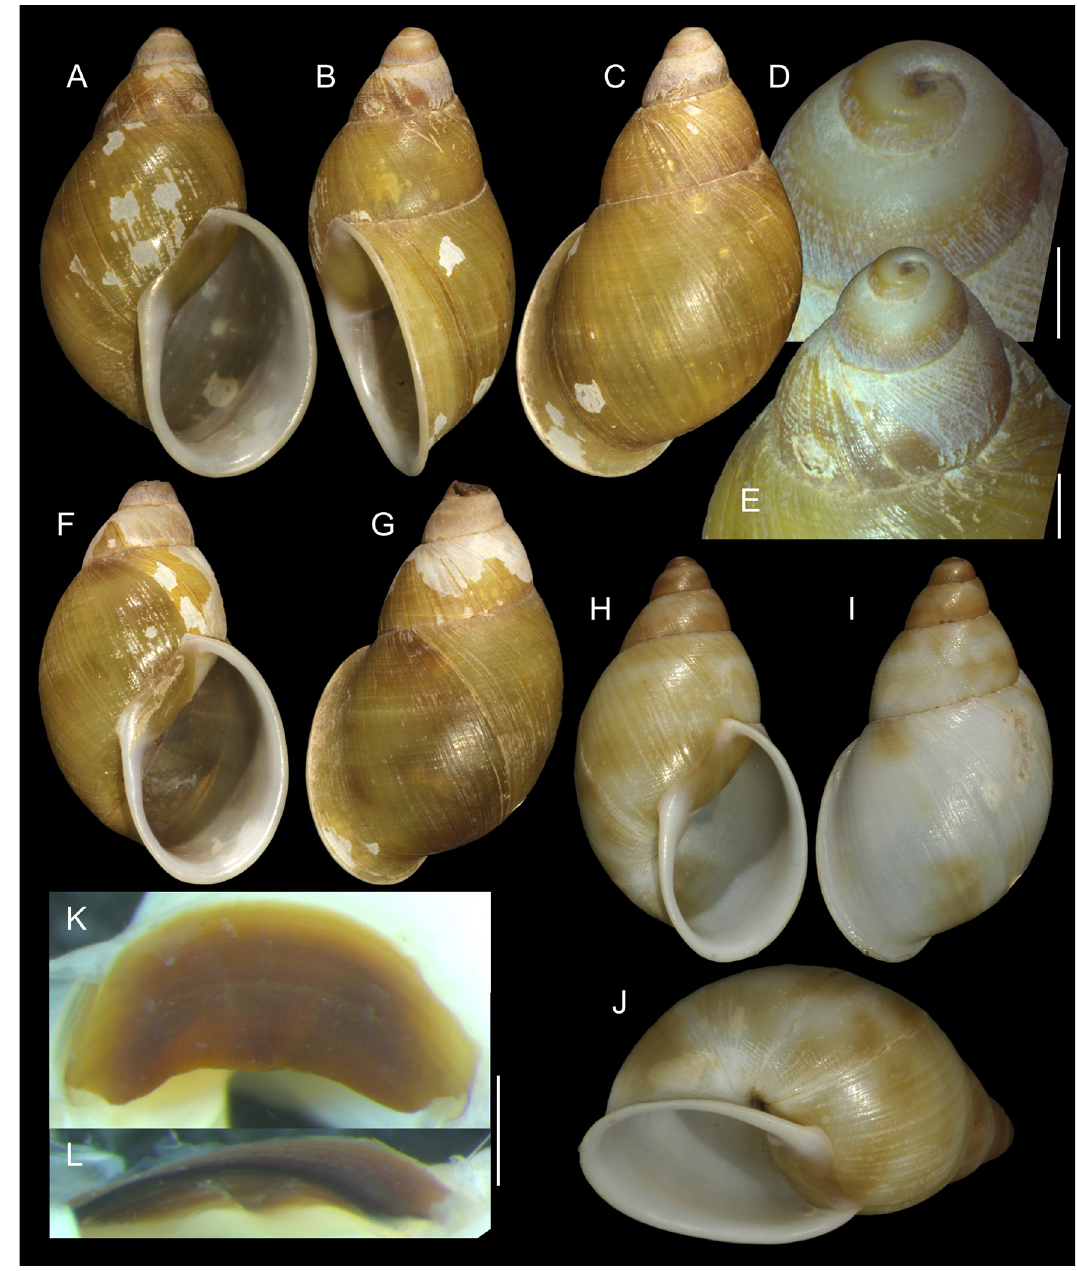
Fig 9. Anthinus vailanti , shells and jaw. (A-E) holotype MZSP 152891 (L 29.0 mm). (A) frontal view. (B) right view. (C) dorsal view. (D) detail of apex, right-slightly apical view. (E) protoconch and adjacent teleoconch whorl, right-slightly apical view. (F-G) paratype MZSP 152188 (L 27.9 mm) frontal and dorsal views. (H-J) paratype MZSP 152244 (L 29.5). (H) frontal view. (I) dorsal view. (J) anterior-slightly left view showing umbilicus. (K) holotype’s jaw plate, ventral view. (L) same, anterior view. Scales = 0.5 mm. cartilage, remaining on m4. Jaw plate broad, with central fold. Radula with elongated, spatula- like mesocone, rachidial slightly different from neighboring teeth. Seminal receptacle widely curved, hermaphrodite duct inserting in its middle region, perpendicularly. Accessory genital gland in spermoviduct large; with single, coiled sperm-groove. Penis ~60% of spermoviduct;